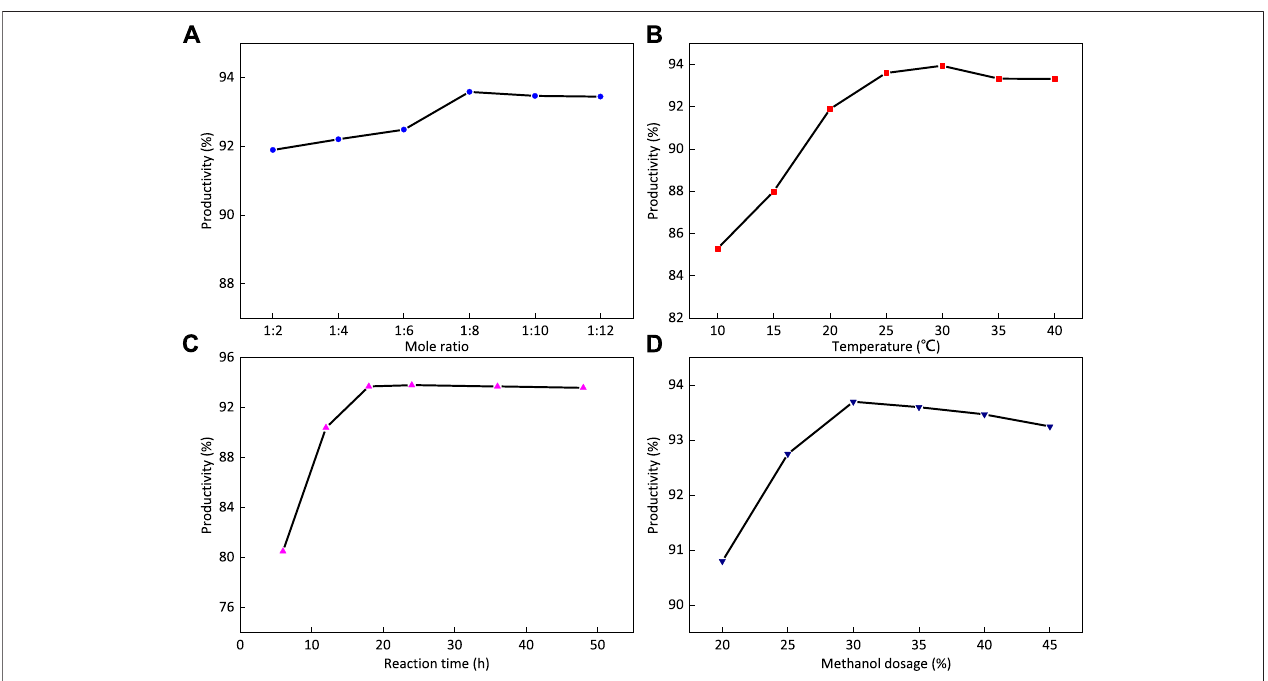
FIGURE 10 | Effects of the ratio of reactants (A) , methanol dosage (B) , reaction time (C) , and reaction temperature (D) on the yield of 2-FOSN hyperbranched molecules.